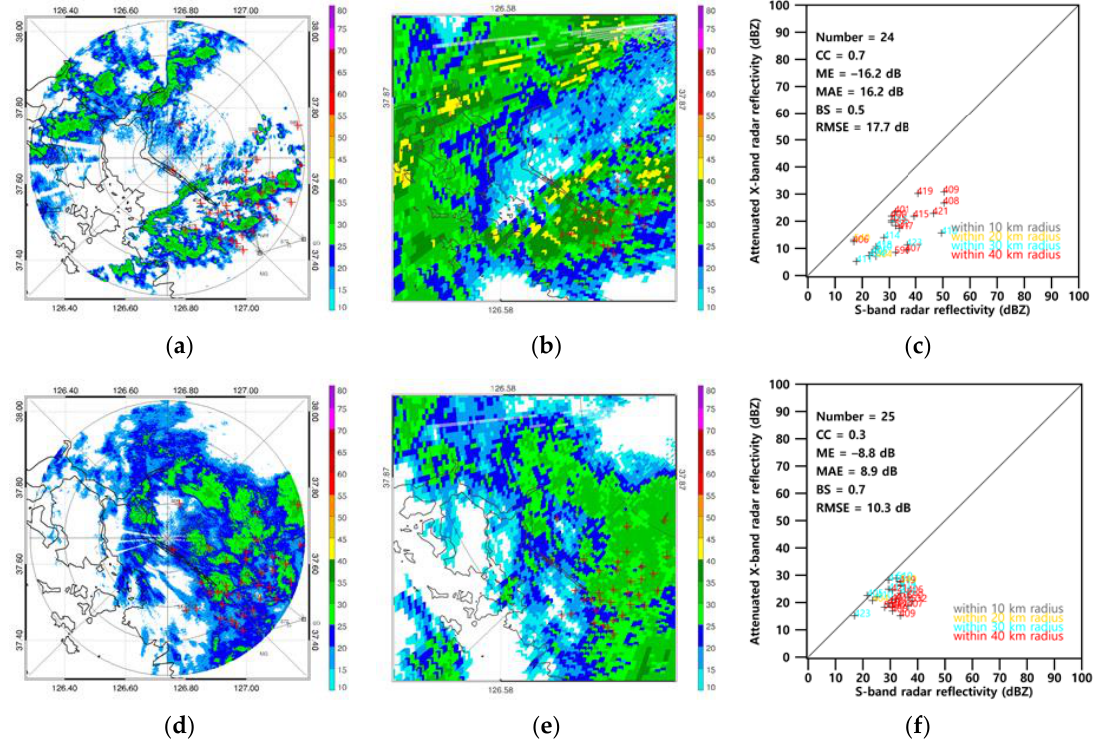
Figure 4. Plan position indicators (PPIs) of reflectivity without attenuation correction during convective rain by ( a ) the X-band radar, ( b ) the S-band radar, and ( c ) a comparison between the two. ( d – f ) are the same as ( a – c ), respectively, but during stratiform rain.